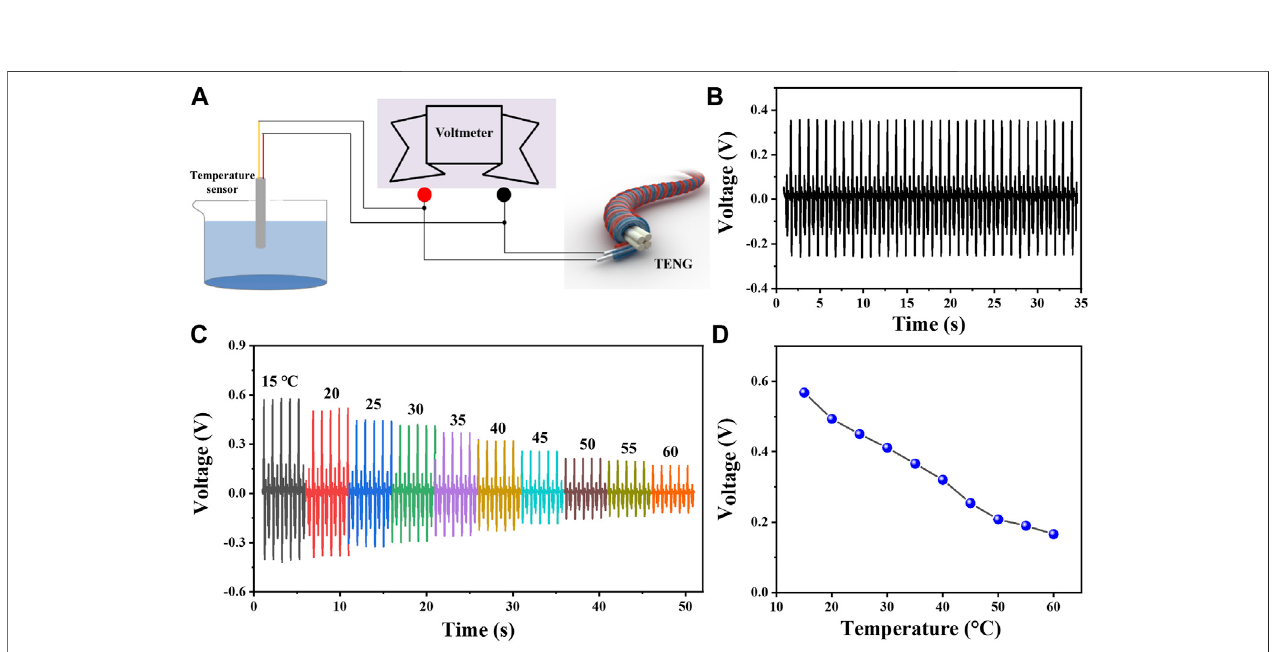
FIGURE 5 | TENG-based self-powered temperature sensor. (A) Schematic diagram of the connecting circuit. (B) Stable voltage curves of the self-powered temperature sensor system working at 36.5 ° C. (C,D) Stable voltage of the self-powered temperature sensor at different temperatures.